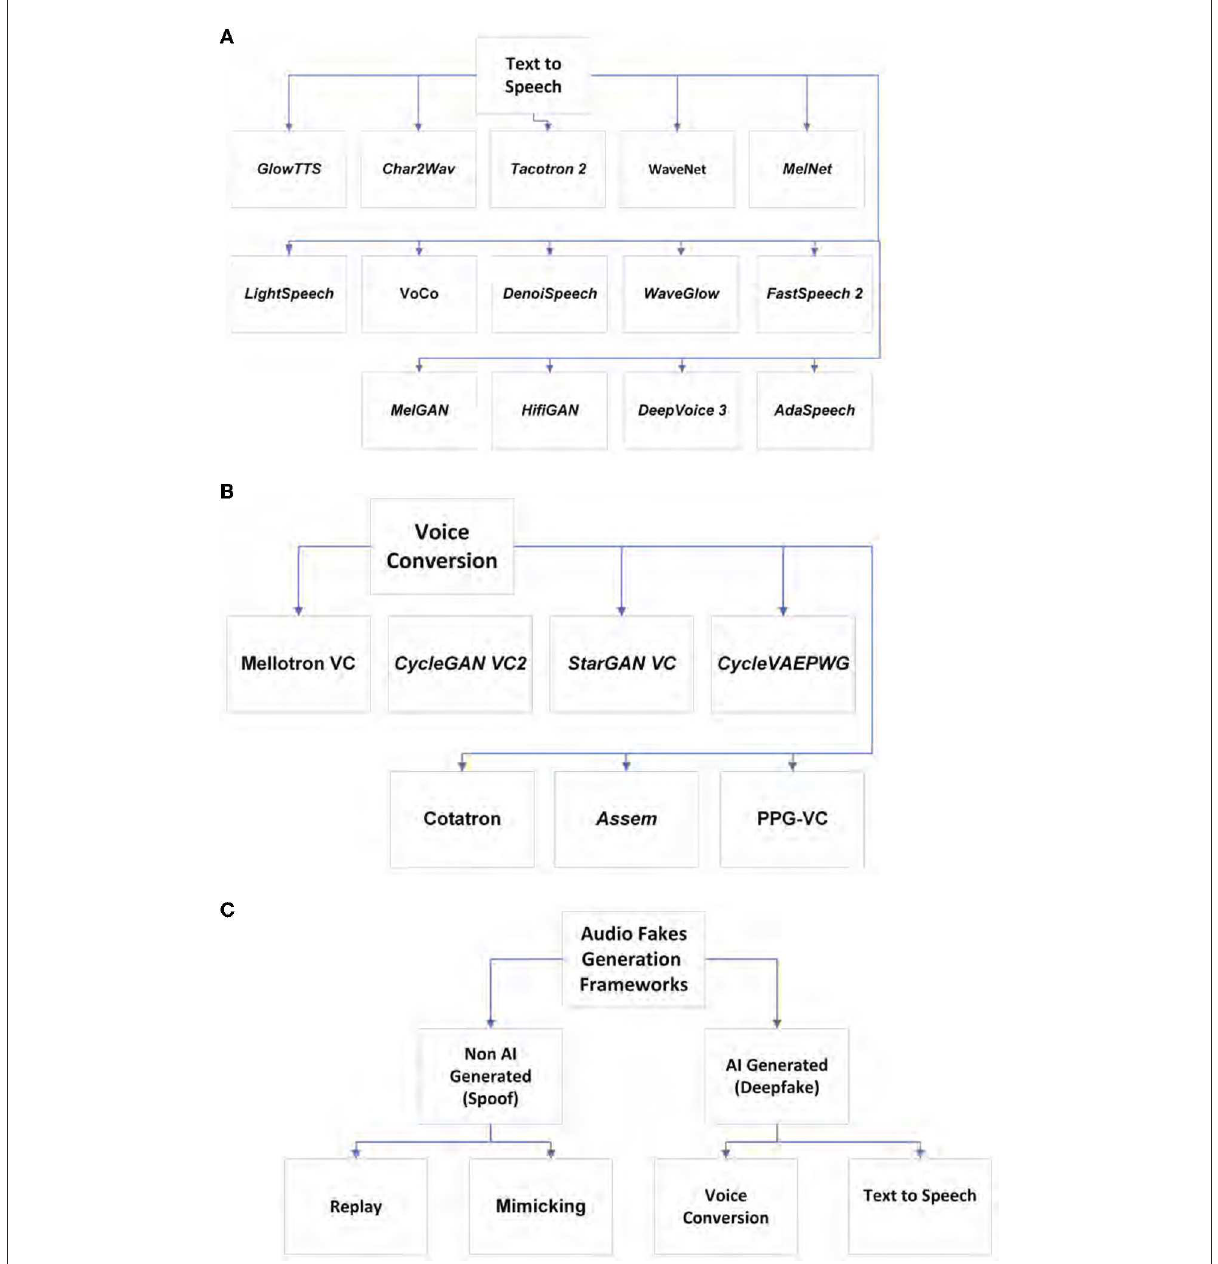
replayed on a phone handset with a loudspeaker. Cut and